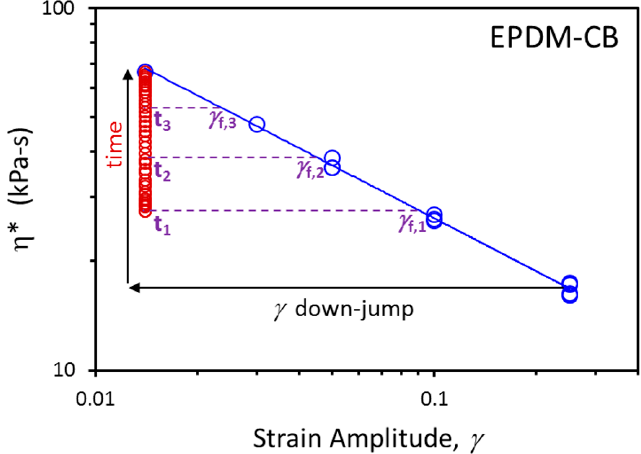
Figure 6. Illustration of fictive strain determination during time-dependent η * build-up (red symbols) at γ = 0.014 after strain down-jump from γ = 0.25 for EPDM-CB. The blue symbols are η * eq vs. γ along with the related power law fit (solid line).